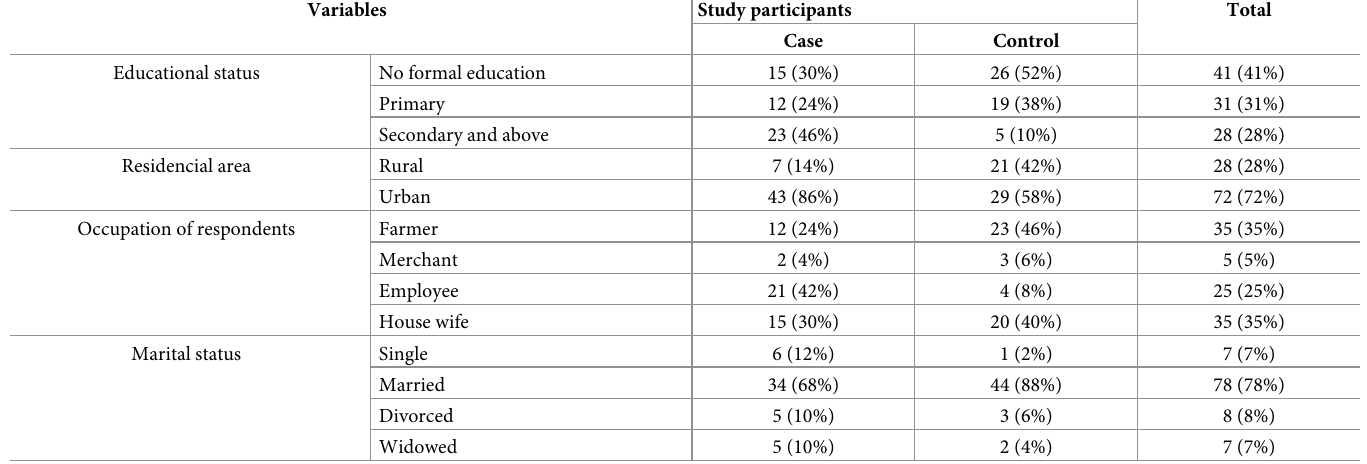
Table 1. Socio-demographic characteristics of study